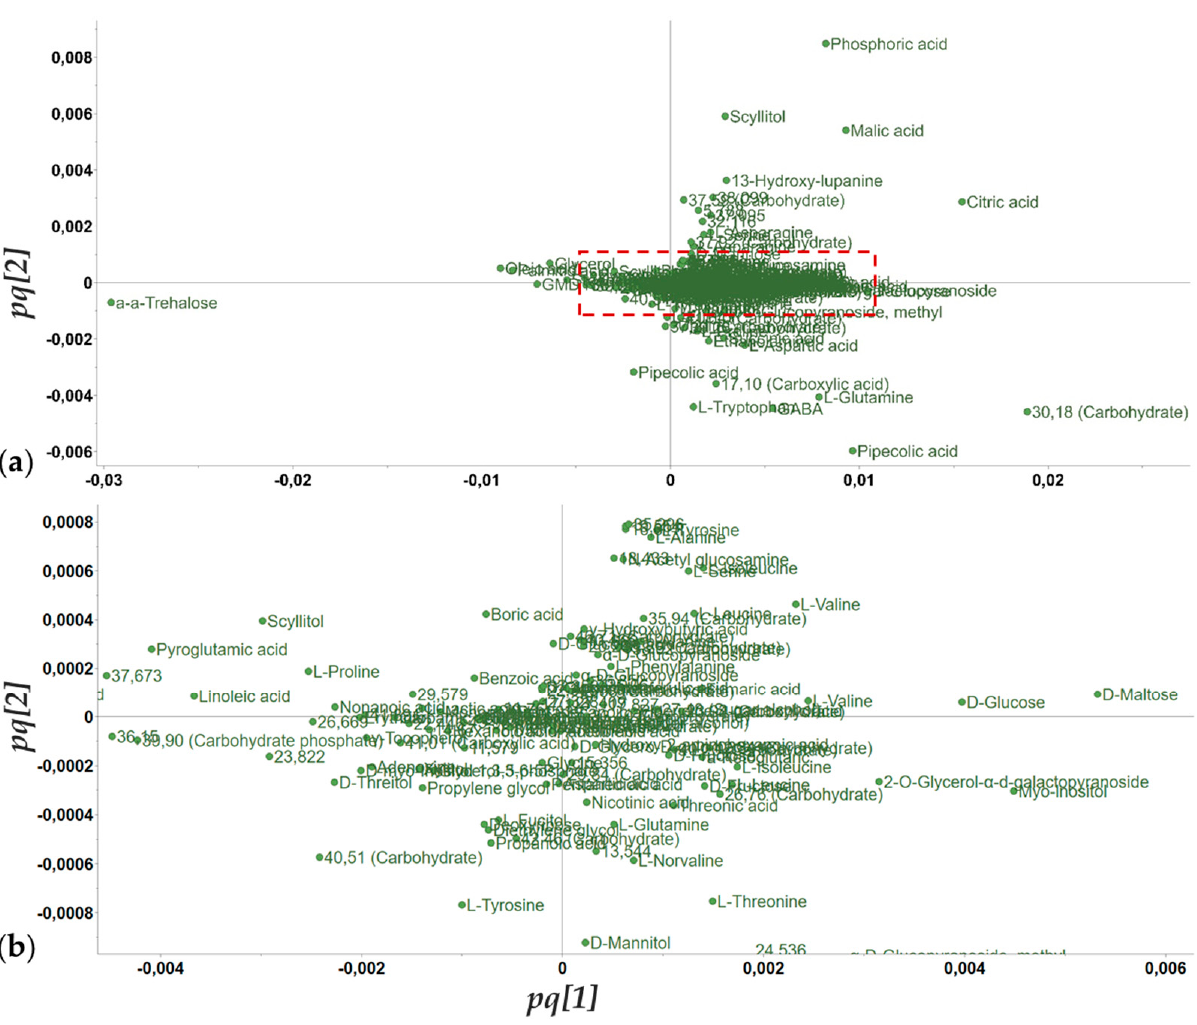
Figure 6. ( a ) OPLS-DA predictive component loading scatter plot for the discrimination among the analyzed Lupinus albus cultivar seeds’ metabolites; ( b ) magnification of the red dashed area of the upper